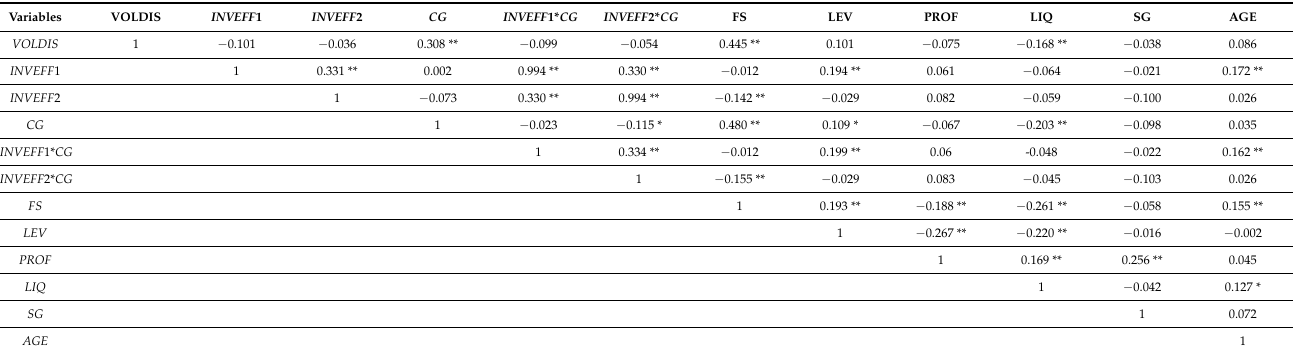
Table 3. Pearson’s Correlation Matrix: Voluntary Disclosure Score.